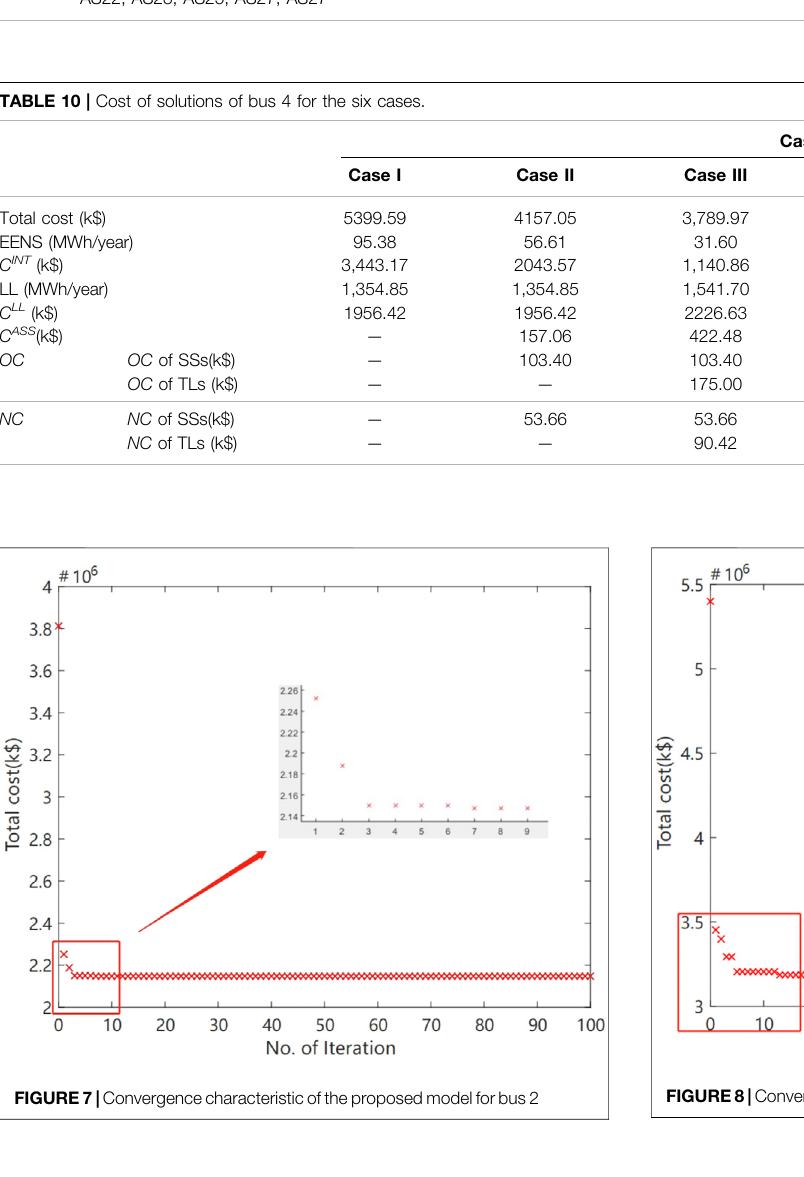
Frontiers in Energy Research |